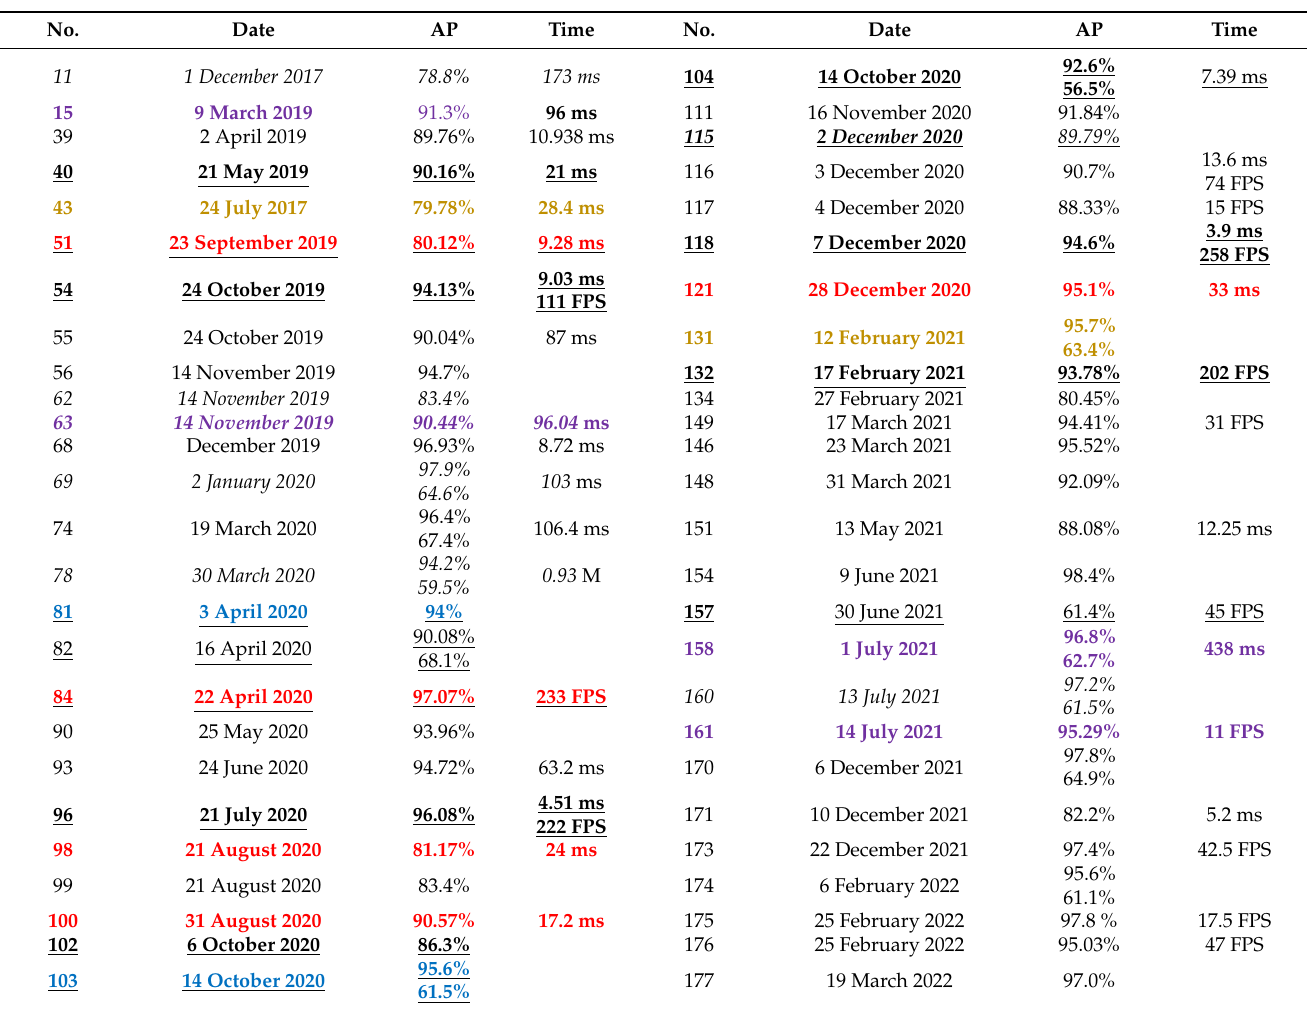
Table 5. The performance evolution of detectors on SSDD (The data come from the 177